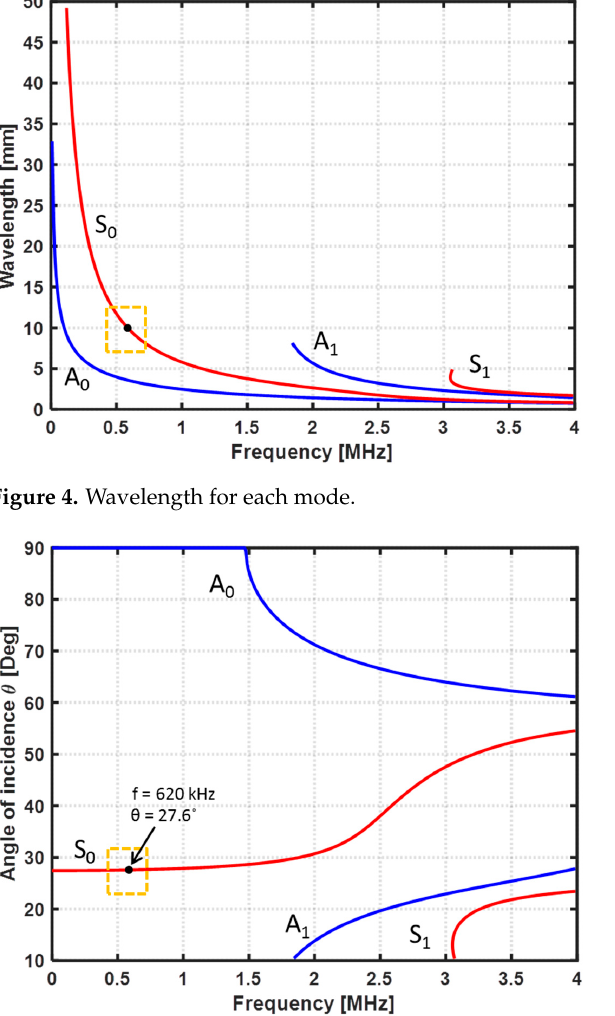
Figure 5. Angle of incidence in the wedge for each mode.